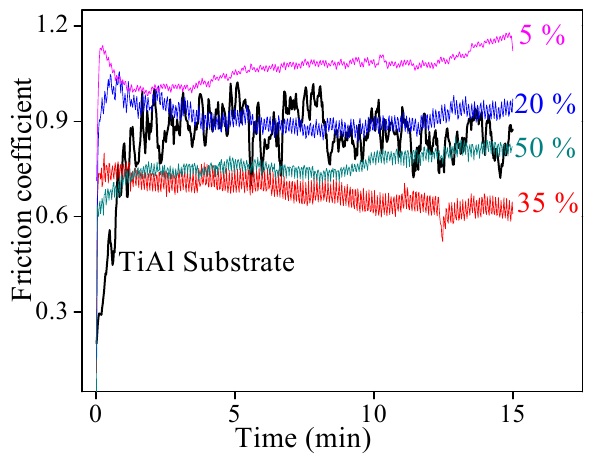
Figure 8. The friction coefficients of TiAl alloy and CPED coatings against GCr15 ball in air under 10 N load for 15 min.